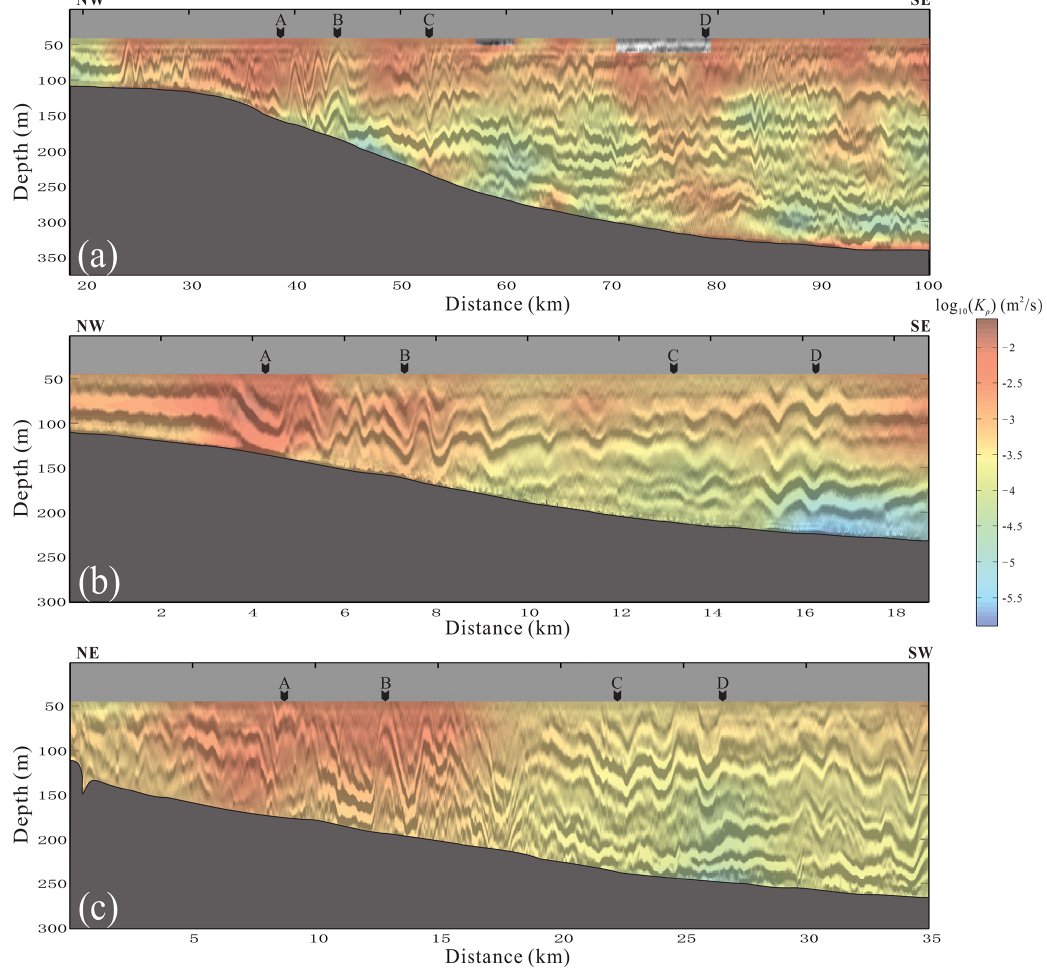
Figure 8. The diapycnal diffusivity map of survey lines L1 (a) , L2 (b) and L3 (c) . The black arrows represent the positions of vertical diffusivity profiles.